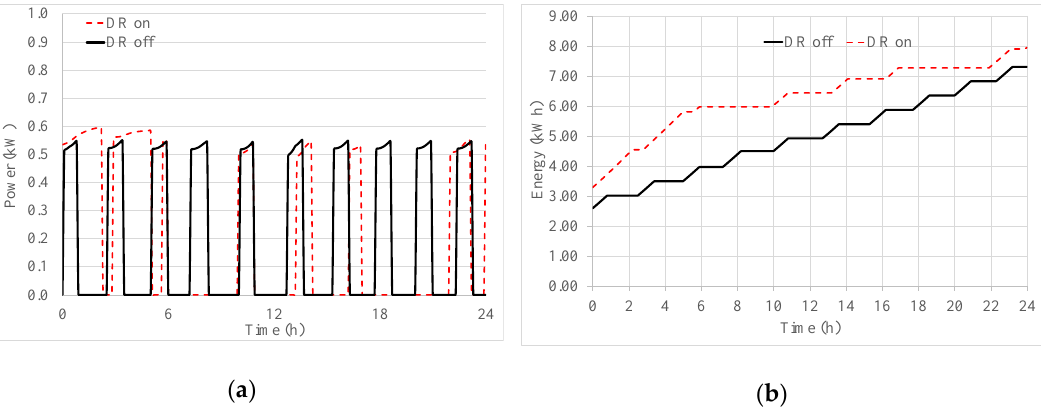
Figure 8. ( a ) Electric power profile and ( b ) cumulative energy curve of the HP with and without the DR program.